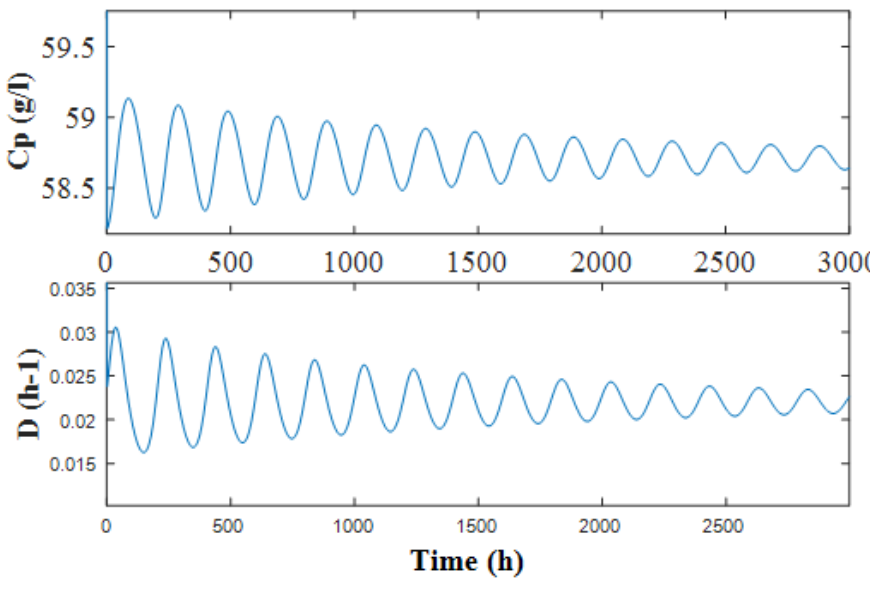
Figure 8. Stabilized outcomes for the closed-loop system, where d = 2 and k =